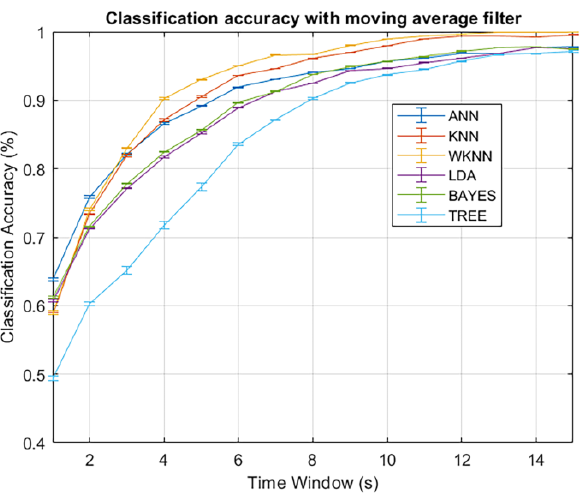
Figure 10. Performances of different classifiers in the second experiment using the moving average filter. average